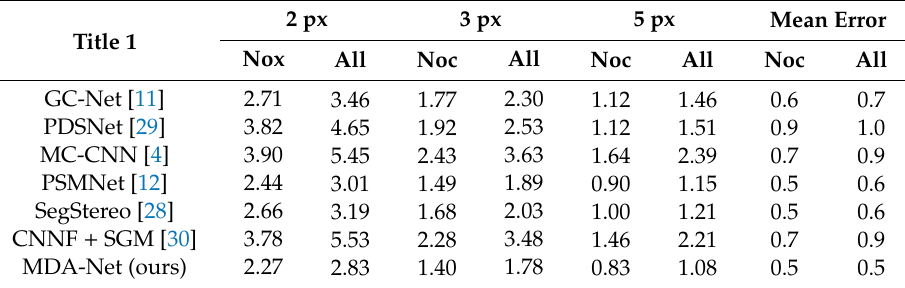
Table 4. The comparison results on KITTI 2012 test